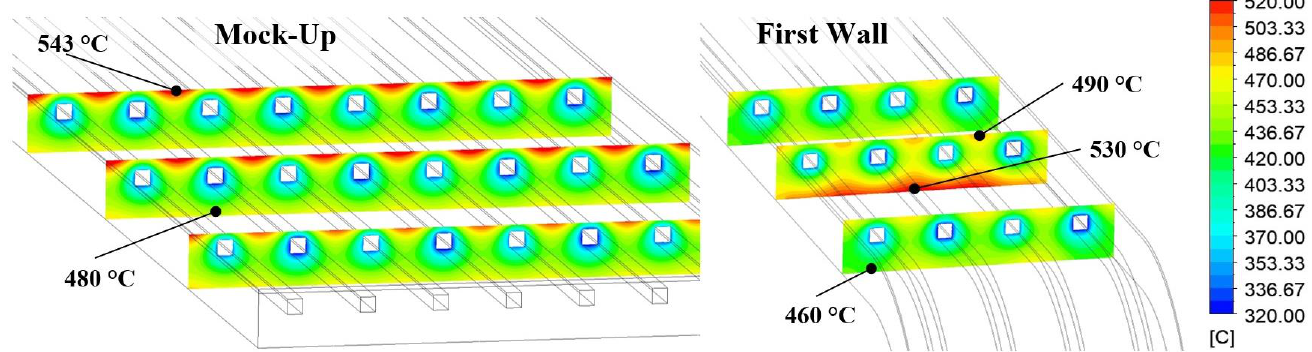
Figure 8. Structure-temperature field for the FW and MU simulations.